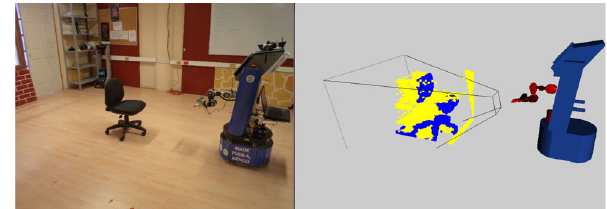
Fig. 3 A mobile robot equipped with a robotic arm, with a Kinect sensor mounted on the end-effector of the robotic arm. Reproduced with permission from Ref. [20], c (cid:2) Springer Nature 2015.